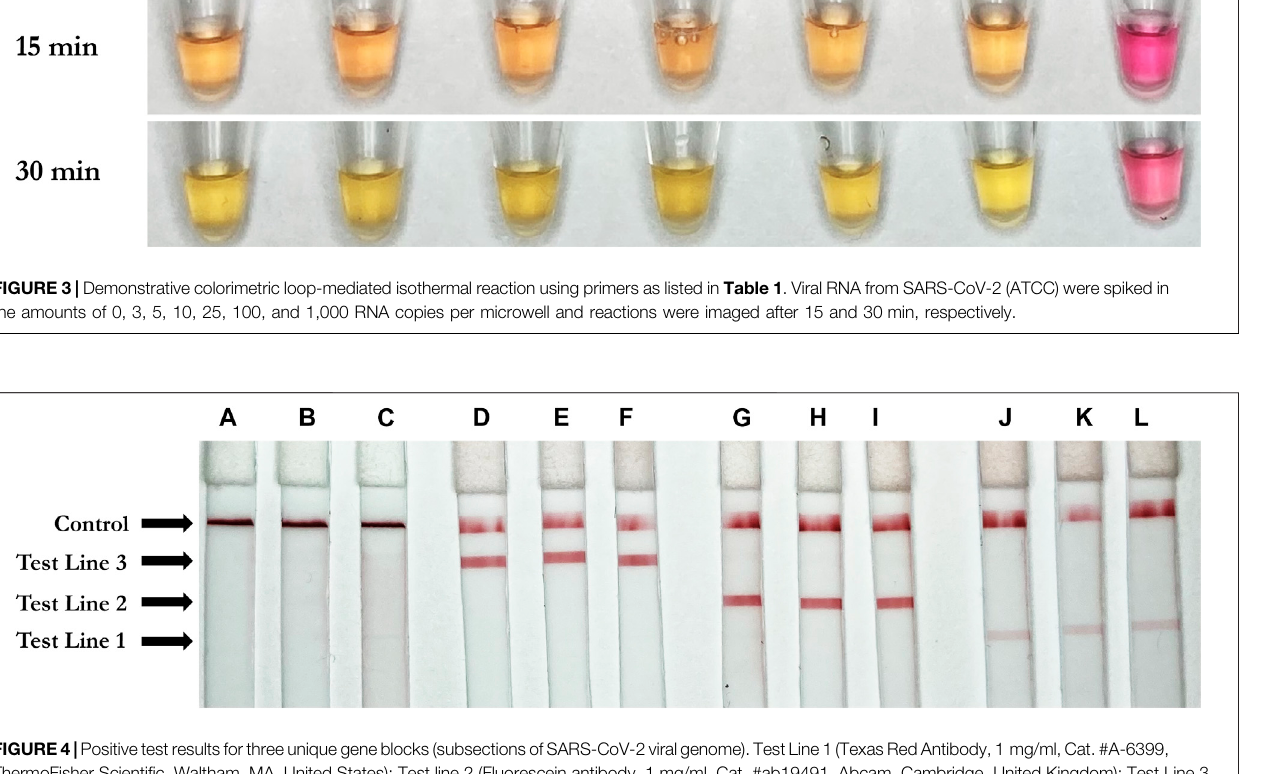
Frontiers in Bioengineering and Biotechnology |